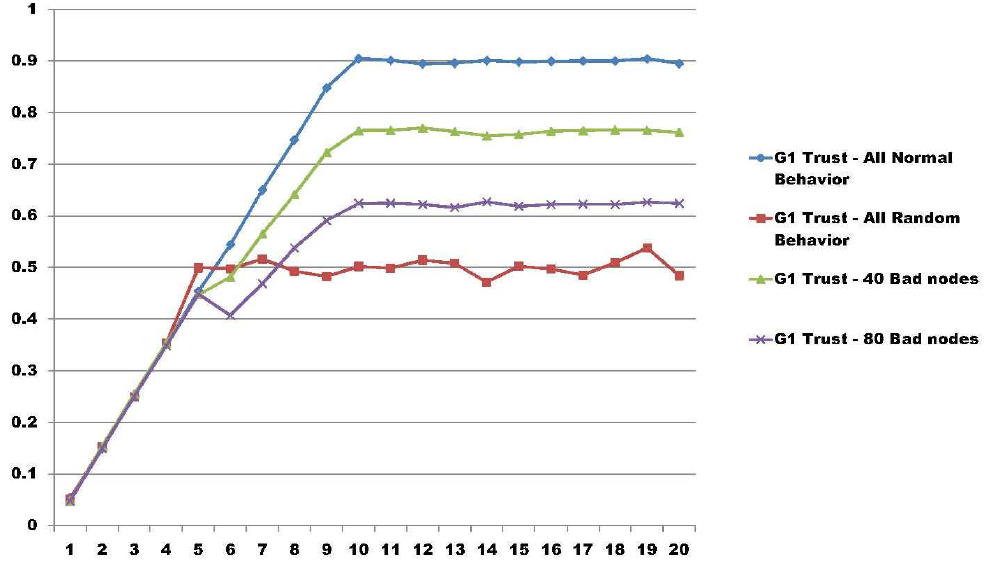
Figure 4. Group trust view for the first